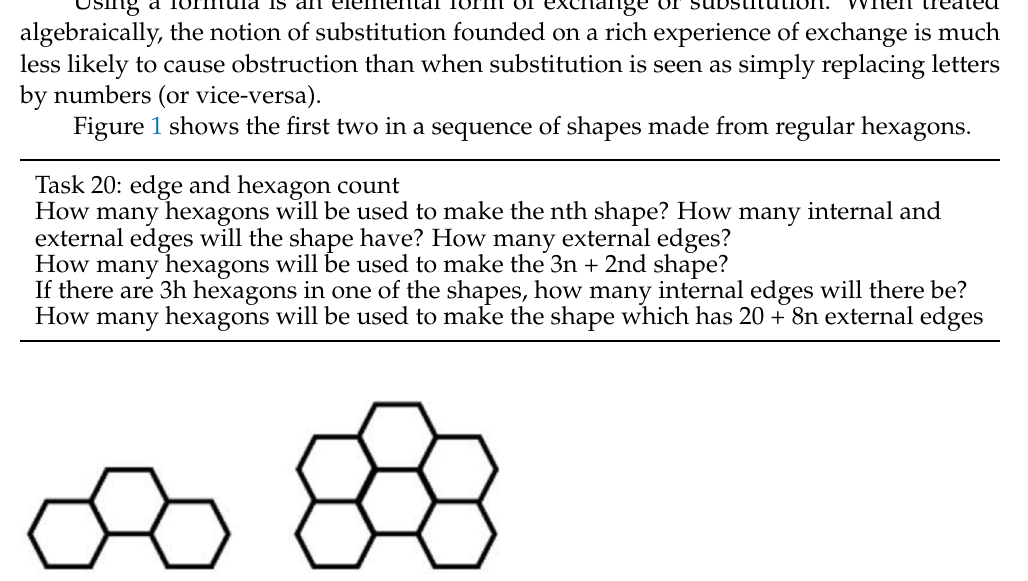
Figure 1. Two stages of a hexagon